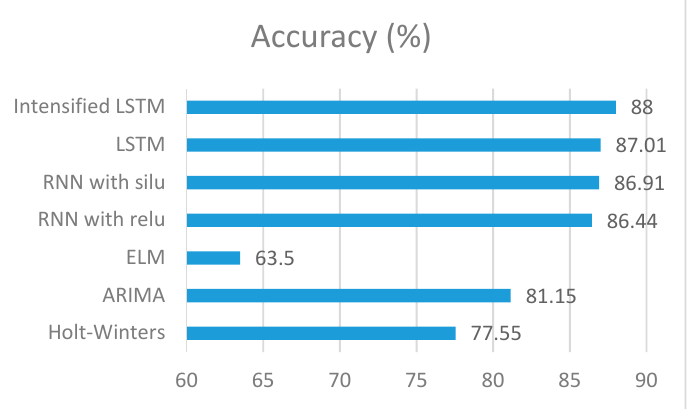
Figure 10. Comparing the accuracies of different prediction models.